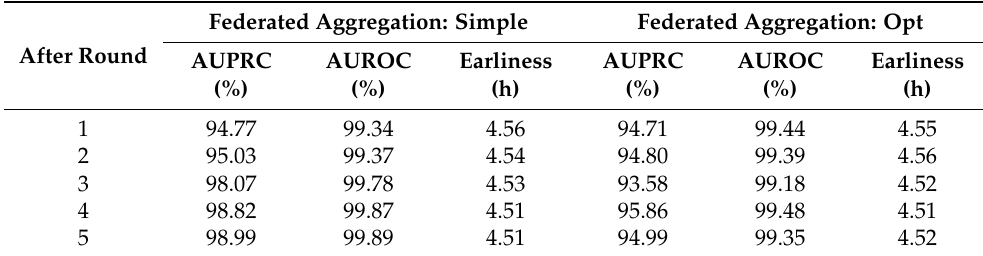
Table 14. Evaluation results using multi-modal (both clinical-text and non-text ) input features in a federated learning setting using three Jetson Nano devices.